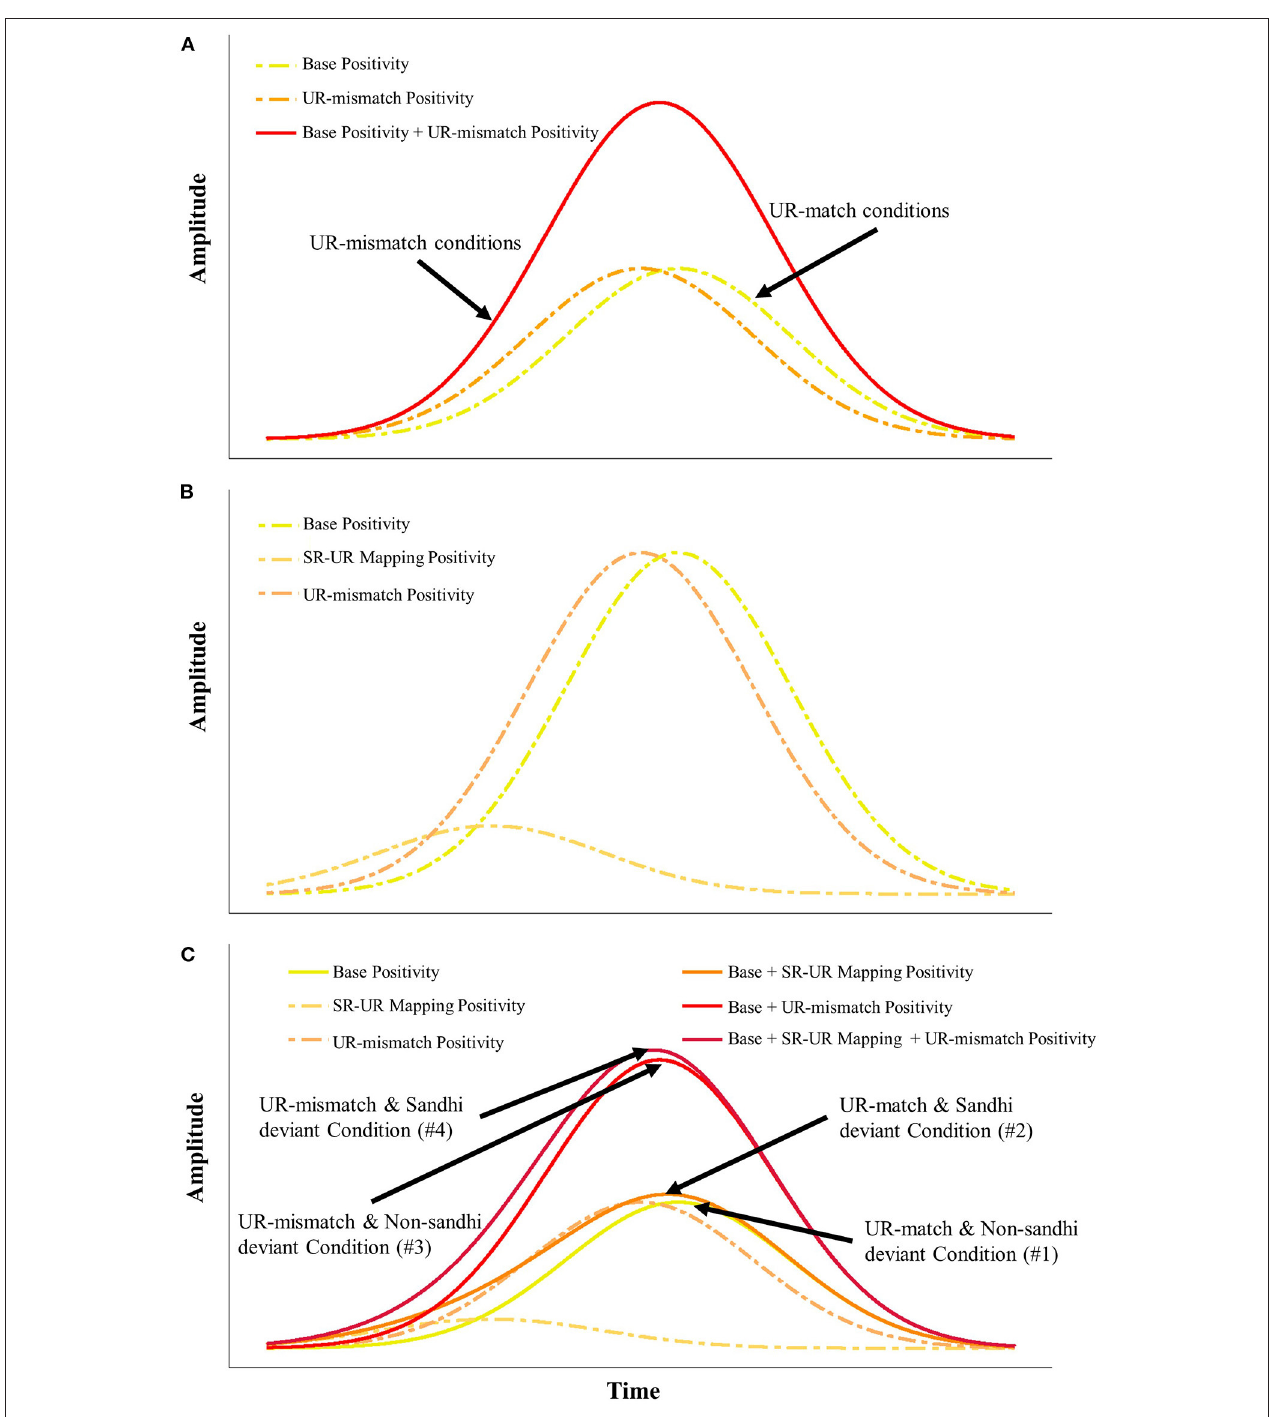
FIGURE 8 | Potential processes involved in the S1-S2 transitional positivity as a function of the component summation. Panel (A) shows the modeling of the UR-mismatch conditions as a summation of Base Positivity and UR-mismatch Positivity. Panel (B) posits the presence of SR-UR Mapping Positivity (for the T3 + T3 deviants), which has an early peak but a smaller amplitude. Panel (C) illustrates how the summation of the three hypothetical components (Base Positivity, SR-UR Mapping Postitivty, UR-mismatch Positivity) could explain the latency and amplitude differences across conditions.